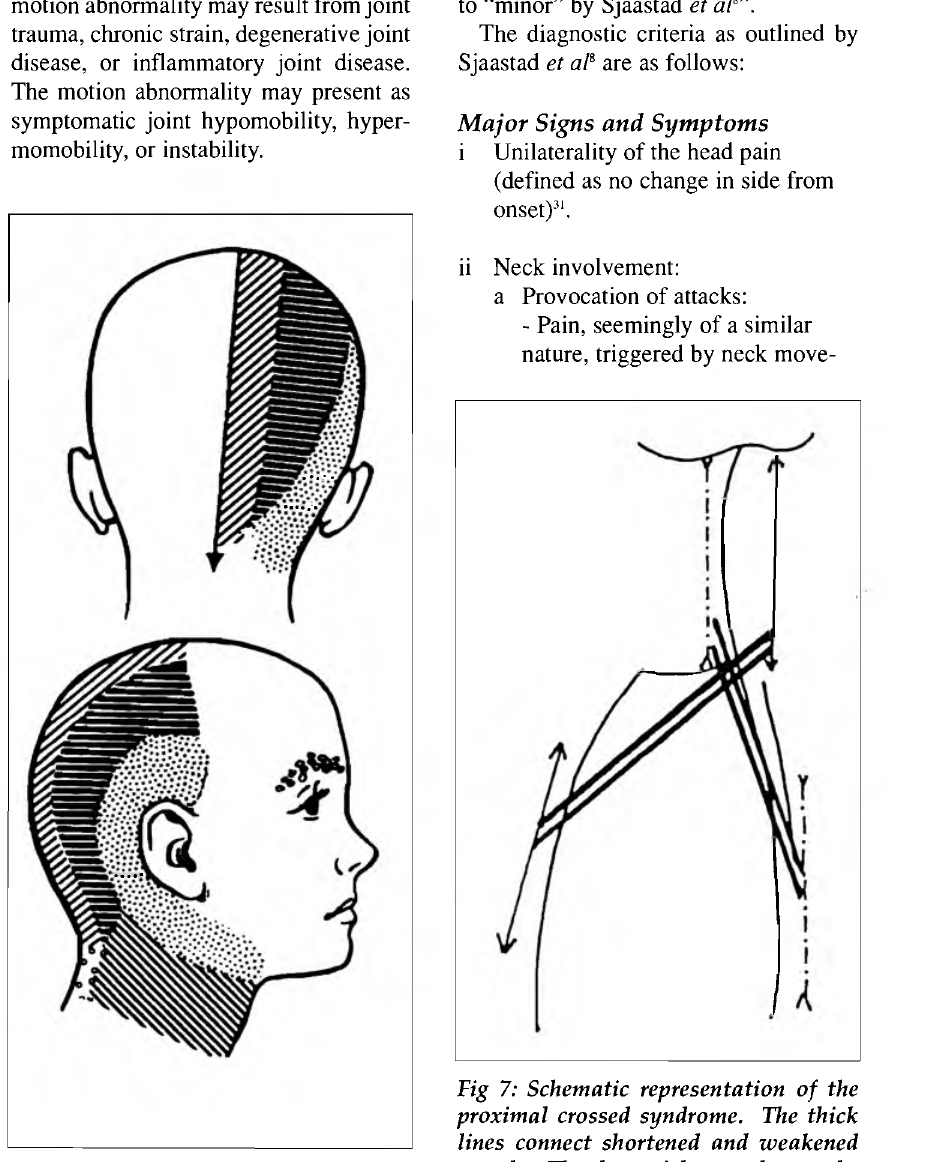
Fig 6: Dermatomic pattern of the anteri­ or and posterior branches of C2 and C3